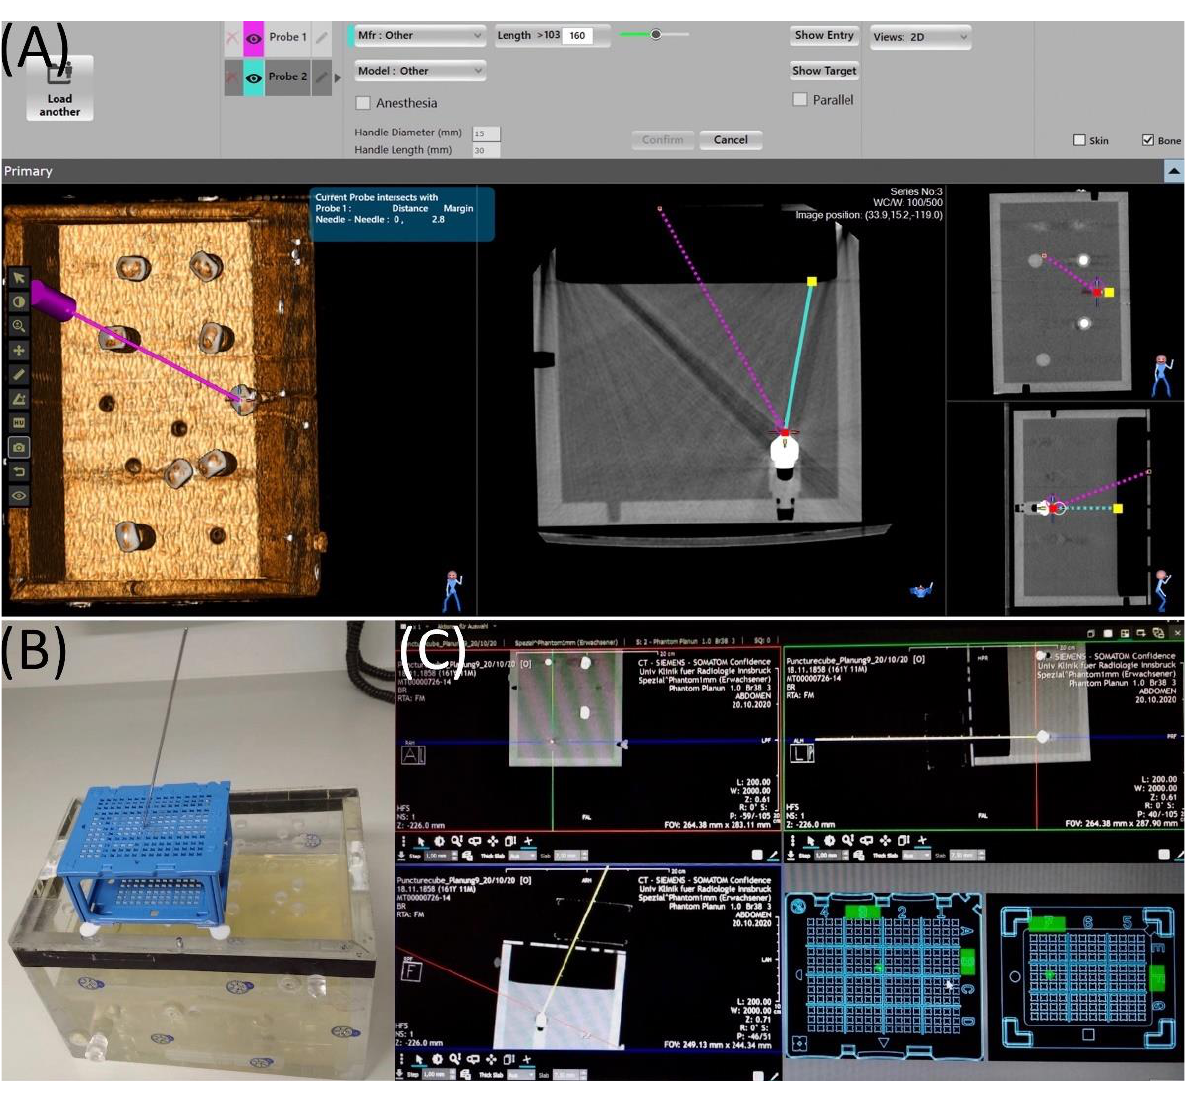
Figure 2. ( A ) Screenshot from the Maxio workstation during the planning procedure of a puncture pathway. Probe 1 (violet path) is confirmed. This picture shows the actual planning of the trajectory of Probe 2 (turquoise line). The red square marks the target point and is already placed on the aluminum tip. The entrance point (yellow square) has to be defined in a next step. All three planes can be used for this purpose. ( B ) The PC is mounted to the phantom. ( C ) In the PCS planning software the target (crosshair) as well as the trajectory of the needle can be freely moved. When a valid needle path has been selected, the corresponding holes given by the software are highlighted in green.